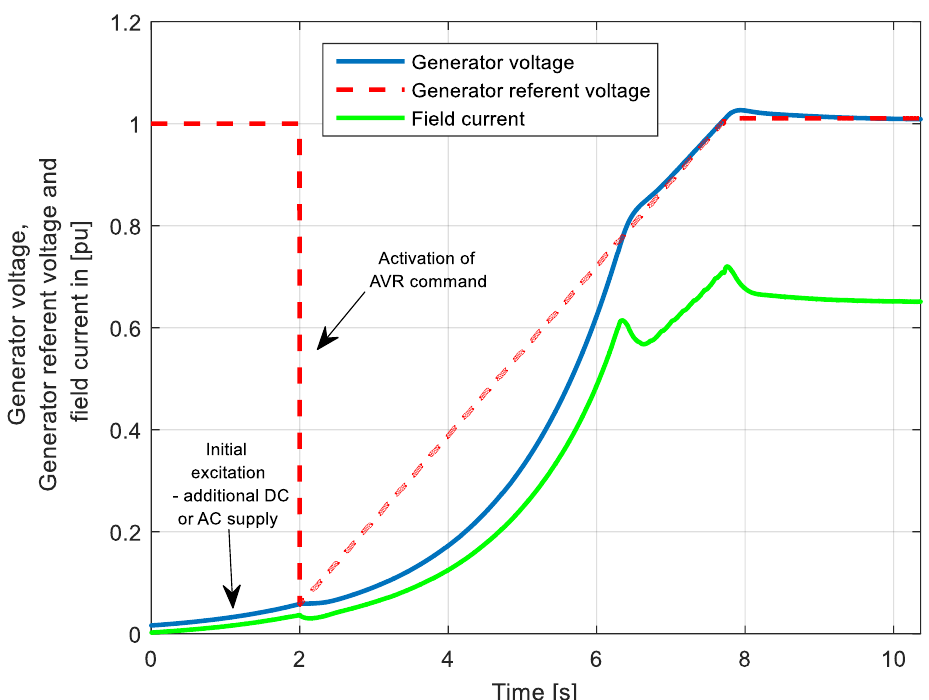
Figure 5. Experimentally measured generator voltage, generator referent voltage, and field voltage during starting excitation in the AVR shunt mode.